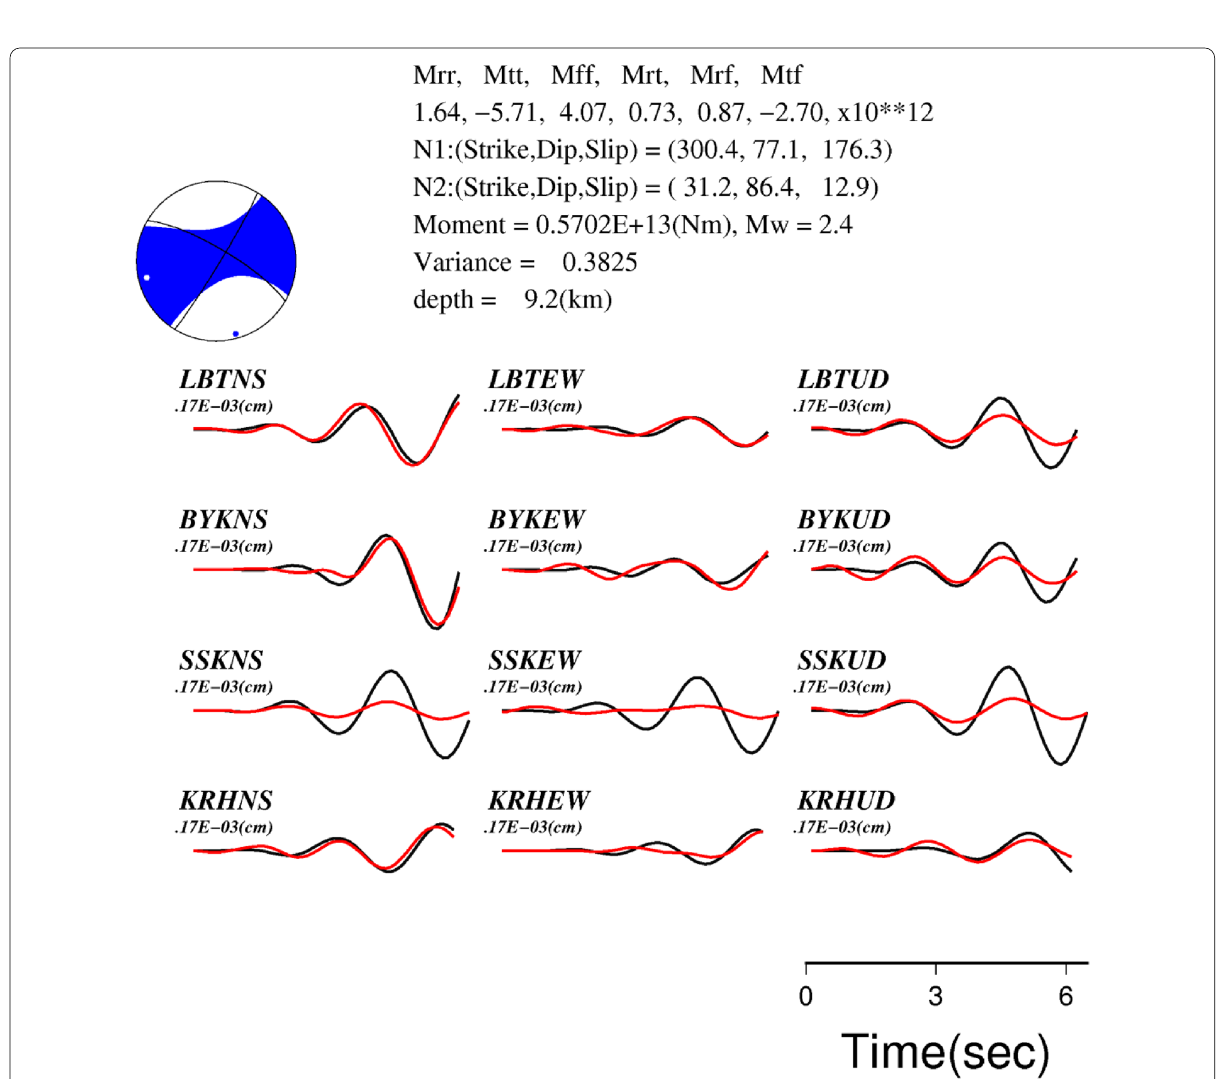
Fig. 3 The original output of the focal mechanism process of a large event that occurred on 29 October 2010 at 02:47 (event ID: 1010290247). The black and red lines are observational and synthetic waveforms,